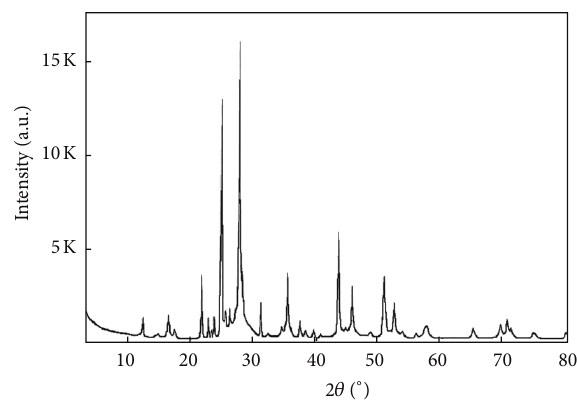
Figure 1: Powder X-ray diffraction pattern of title complex.